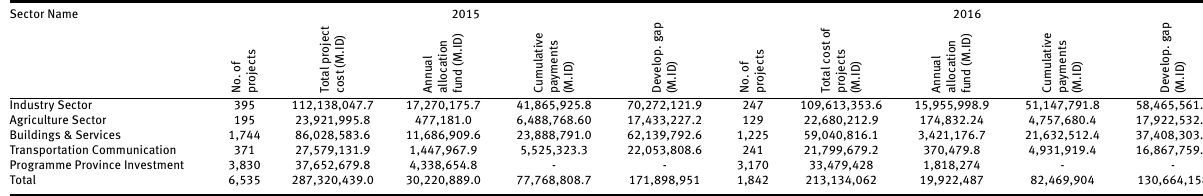
Table 1A: Situations of Investment Plan Projects for 2015 to 2018* SectorName